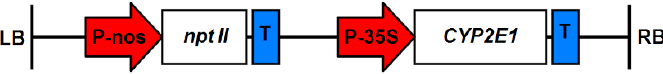
Figure 1. The vector pSLD50-6 harboring the expressing gene P450 2E1 which was used to produce the transgenic S. grandiflora and A. thaliana plants used in the current study